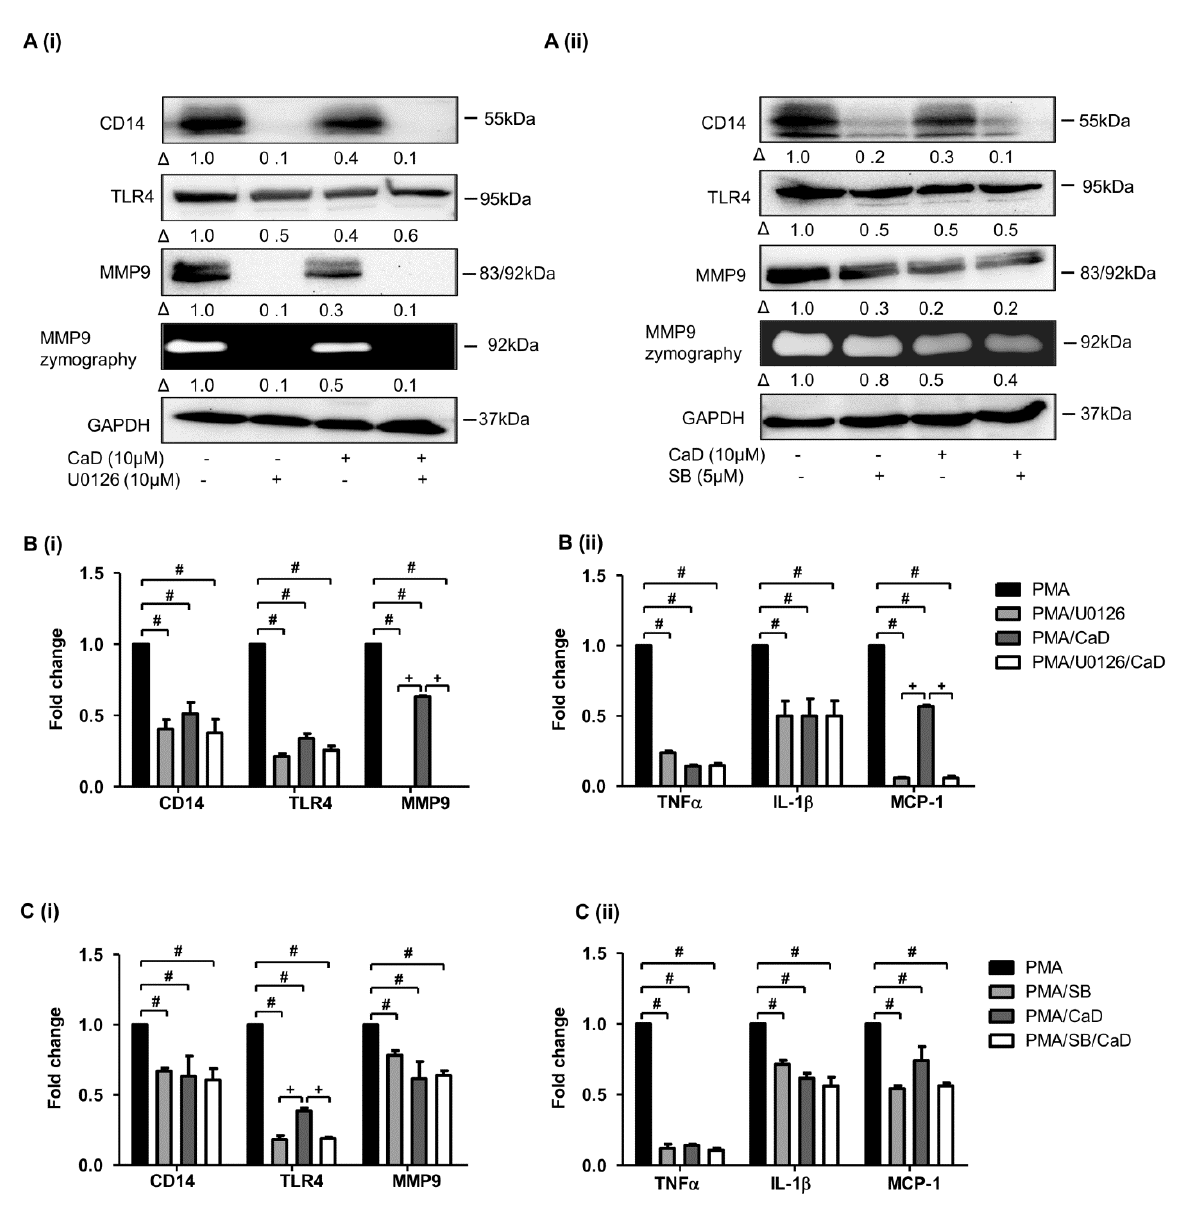
Figure 7. CaD suppresses the MAPK signaling to abolish monocyte-to-macrophage differentiation and inflammation. THP-1 monocytes were pretreated with an ERK1/2 (U0126) or P38 inhibitor (SB203580) for 1 h, followed by CaD for 1 h, and then treated with PMA (30 nmol/L) for 72 h. The differentiation and inflammation markers expression were measured by Western blotting ( A ), MMP9 activity was measured by gelatin zymography, and transcript levels ( B , C ) were measured by quantitative RT-PCR. Δ , fold-change, normalized to PMA only ( n = 3, mean ± SEM. + p < 0.05 vs. inhibitor treatment, # p < 0.05 vs. PMA only, one-way ANOVA). The Western blots represent one from at least three independent experiments.